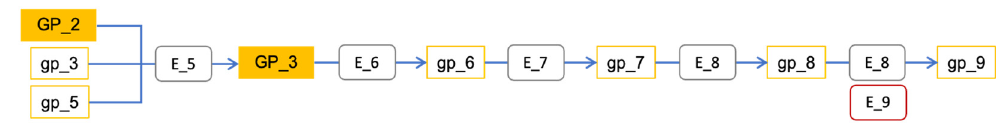
Figure 3. Visual diagram showing connections between the products of GP and evidence ad- vanced during Ilaria’s DGE exploration. during Ilaria’s DGE